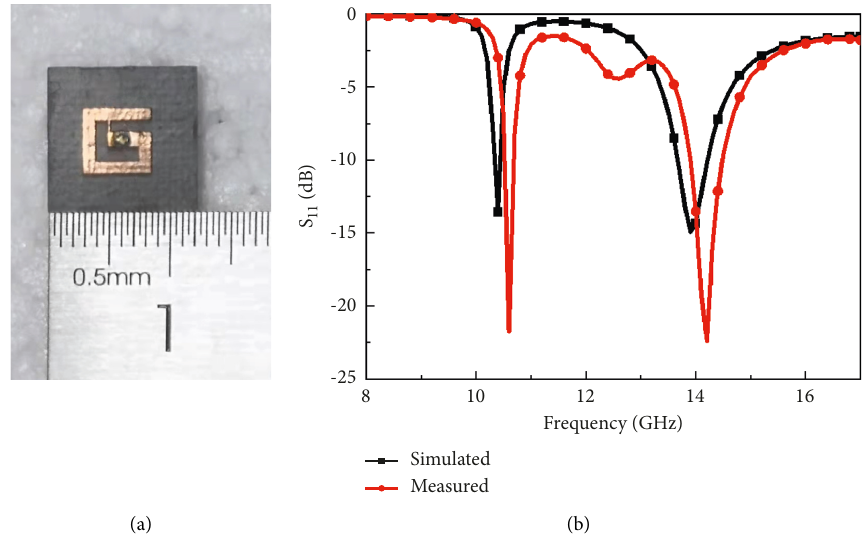
Figure 7: (a) Fabrication of the proposed antenna. (b) Simulated and measured S